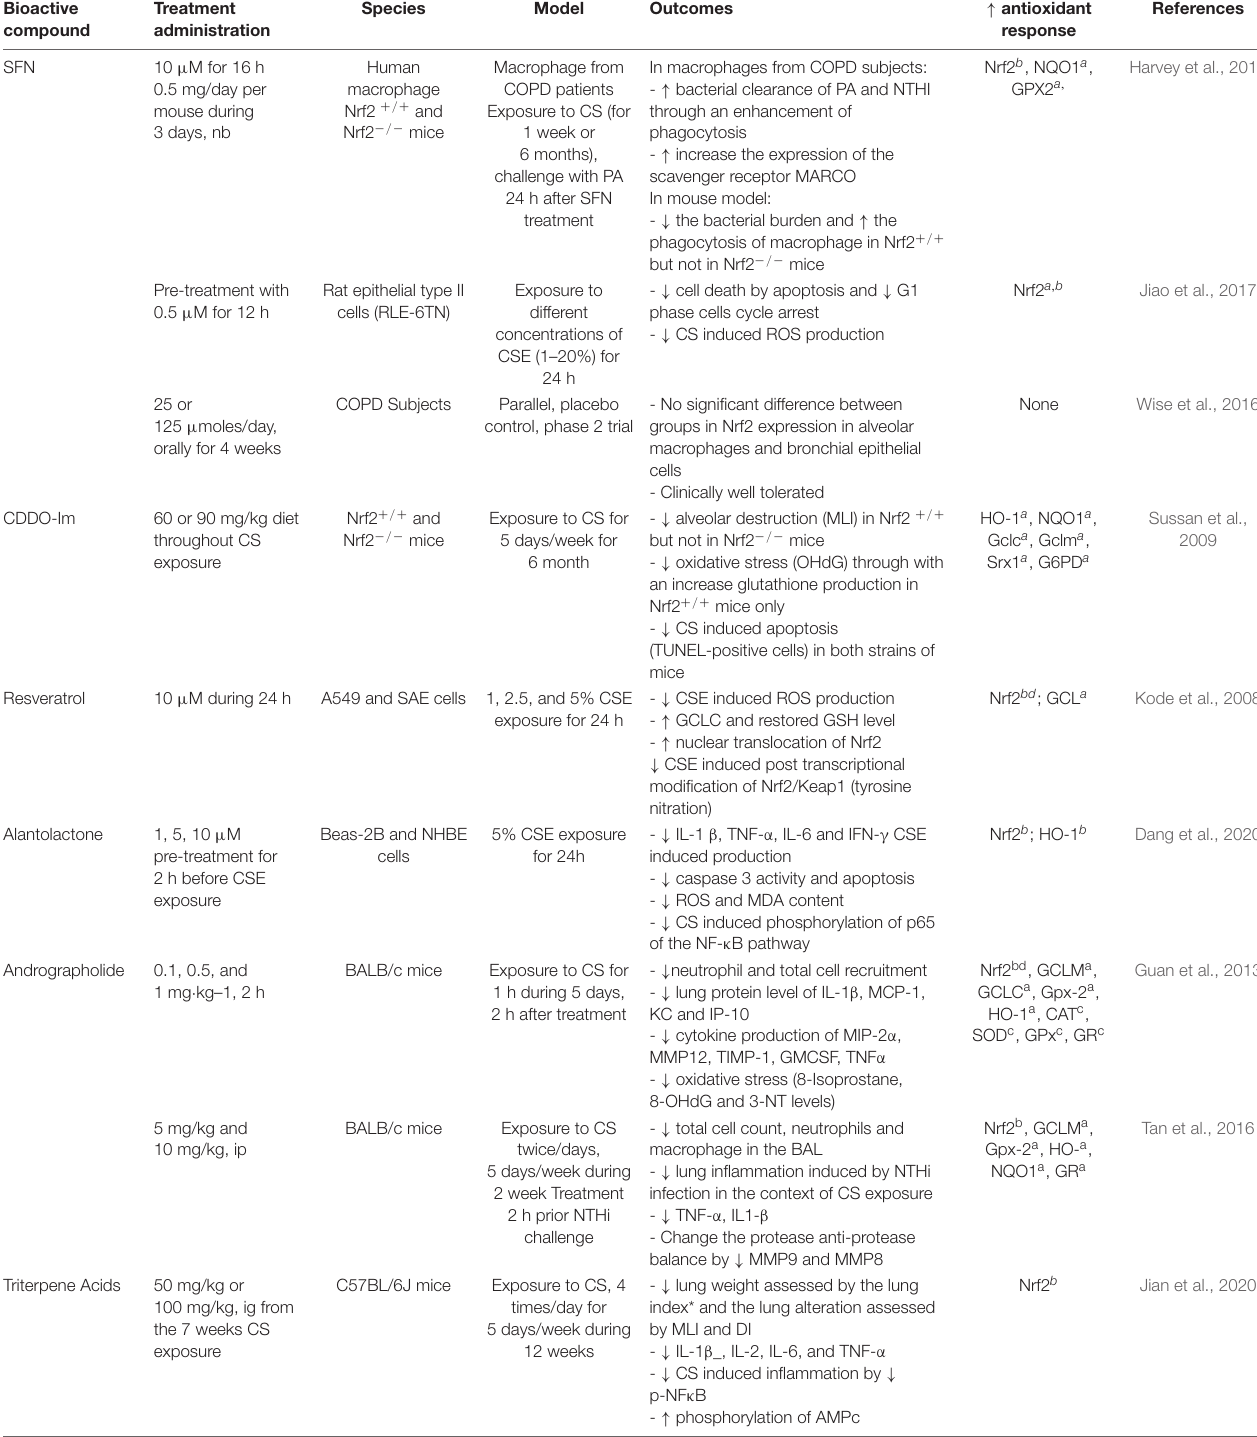
TABLE 1 | Effect of Nrf2 modulation on COPD